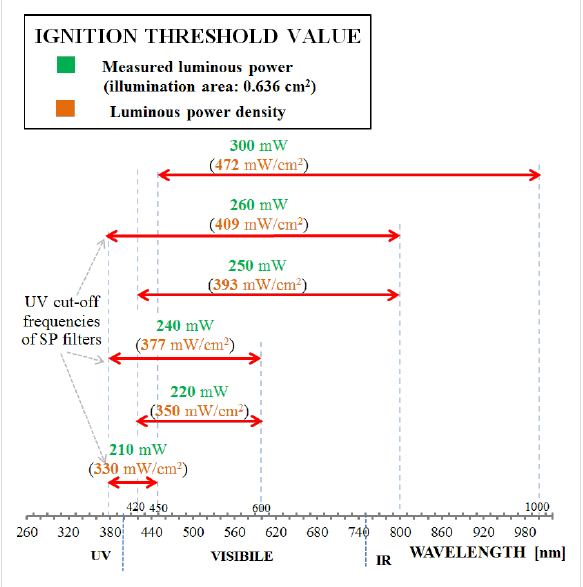
Figure 13: Light power thresholds for ignition using band pass filters.